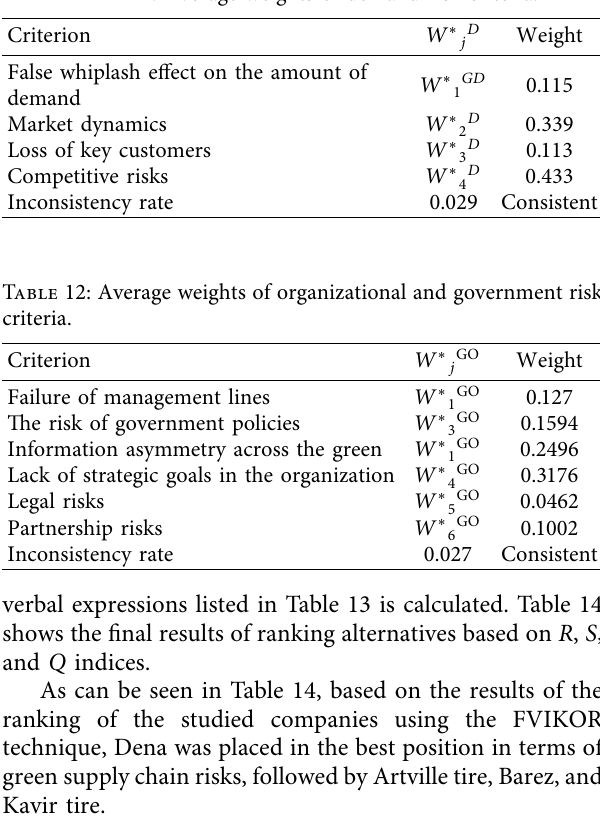
Table 11: Average weights of demand risk criteria.